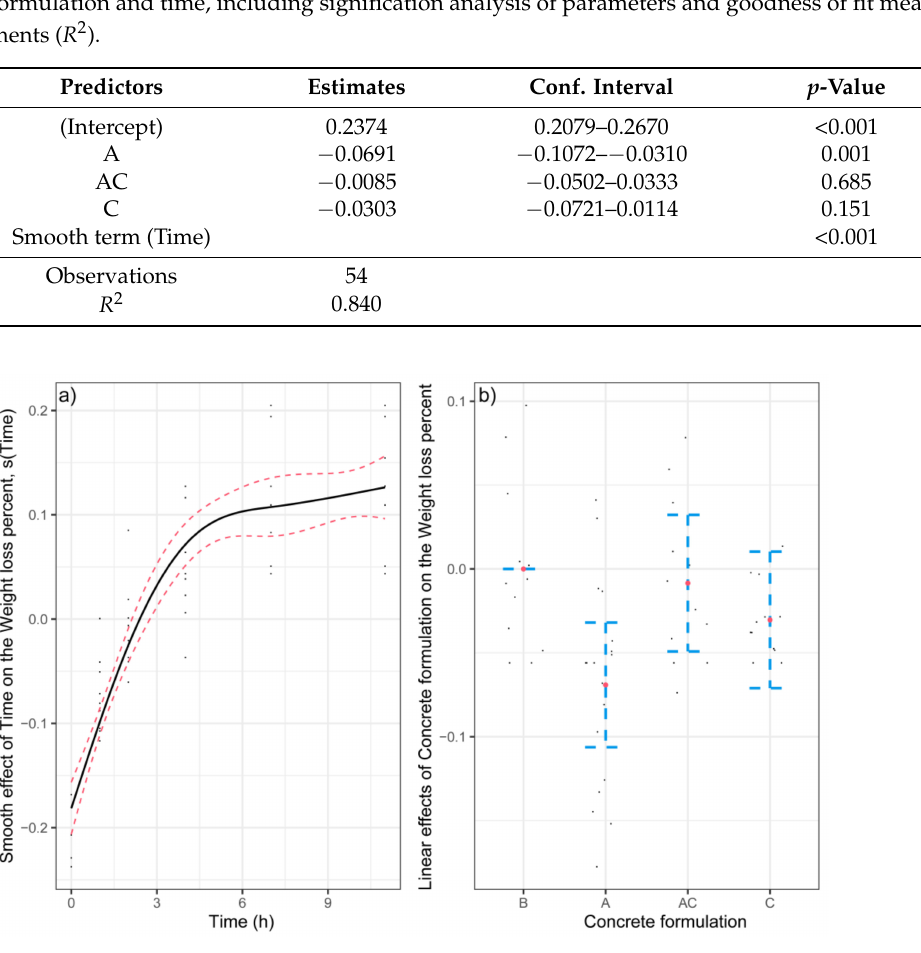
Figure 11. Effects time and concrete formulation on the weight loss percent estimated using the GAM model. ( a ) Smooth effect of the time (adding a 2 standard error width confidence bands. ( b ) 95% confidence intervals for the linear effects of concrete formulation, assuming the B level (concrete without mussel) as the reference. The A formulation is the treatment where the 20 wt.% of sand is replaced by mussel shells, the B level is the control treatment, in the C treatment, the 10 wt.% of cement has been replaced, whereas in the AC treatment, we replace the 10 wt.% of sand and the 5 wt.% of